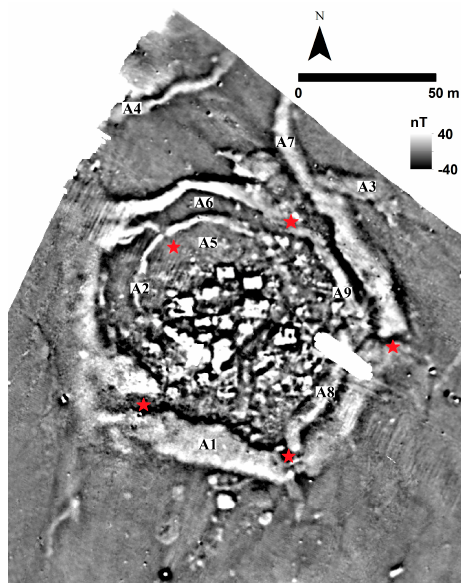
Figure 3. Geomagnetic prospection results from Almyros 2. Red stars indicate possible entrances through the ditch system.